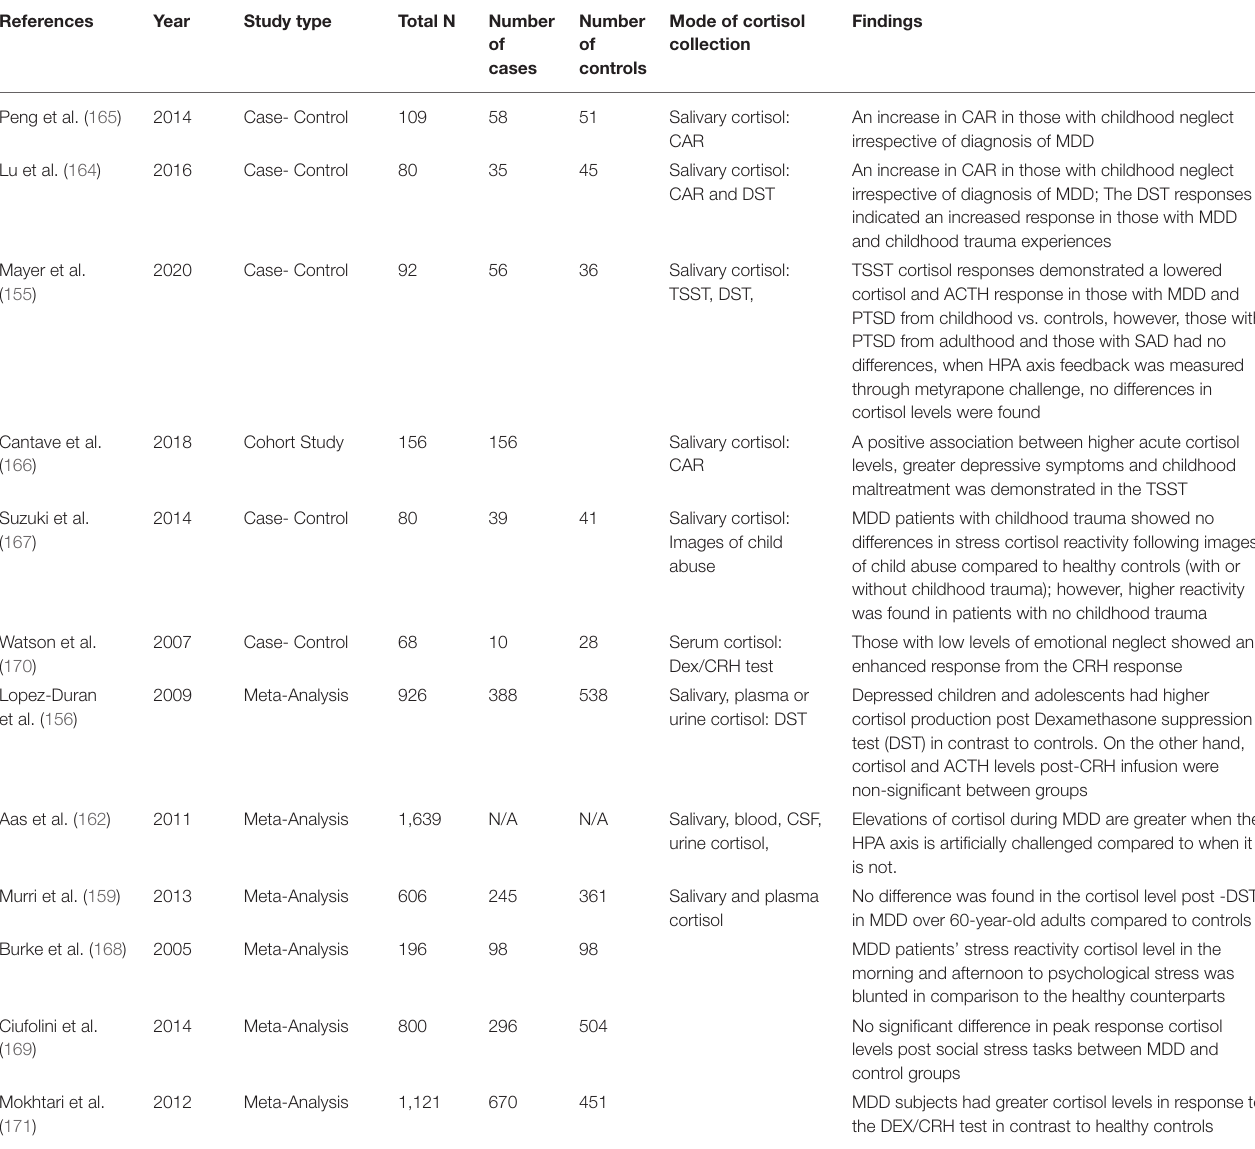
TABLE 2 | HPA responses in